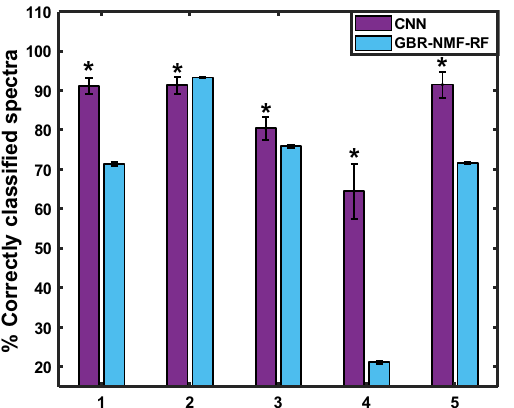
Figure 11. Percentage of correctly classified spectra (test accuracy) corresponding to each mouse being removed from the training set (leave-one-mouse-out validation). Section labels refer to mouse number left out of training